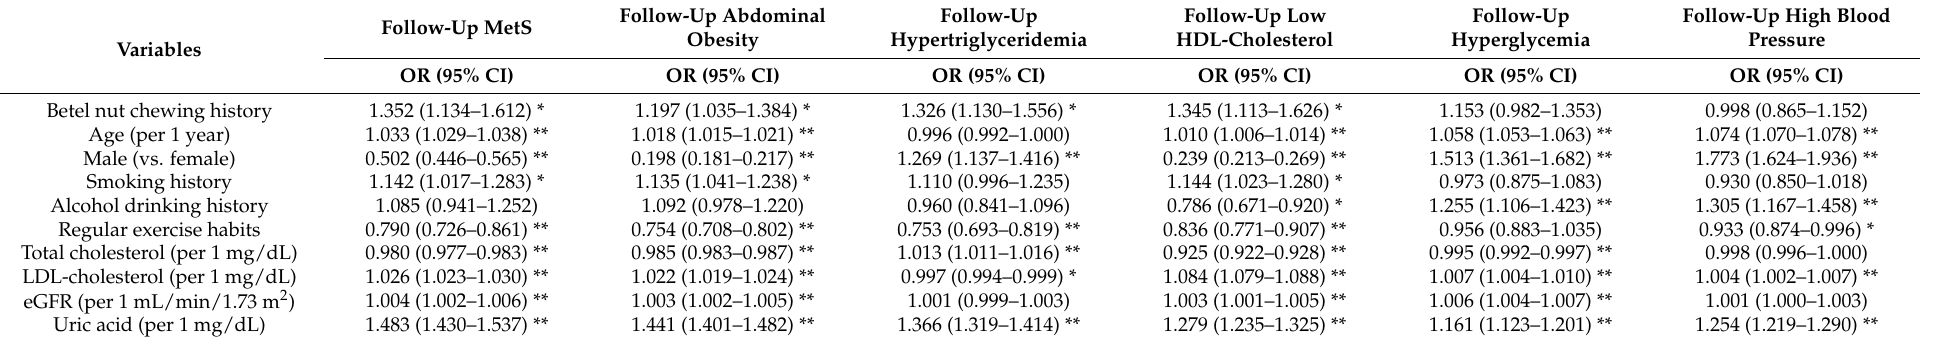
Table 4. Association of betel nut chewing history with follow-up MetS and its components in follow-up participants without baseline MetS ( n = 21,150) using multivariable logistic regression analysis.